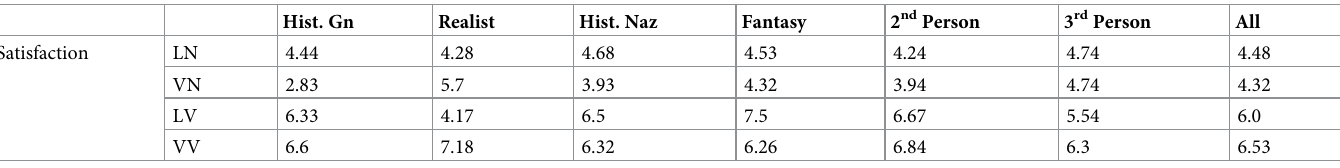
Table 6. Satisfaction by genre and perspective (N =